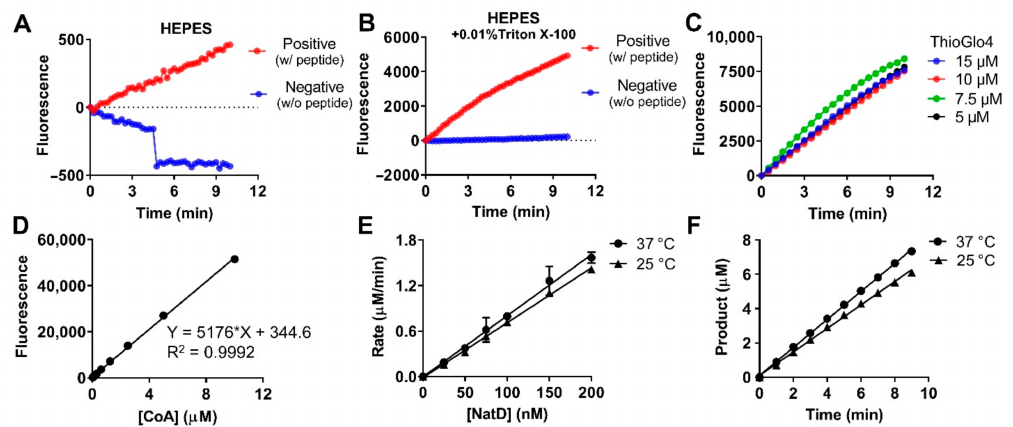
Figure 2. Fluorescence-based NatD activity assay. ( A , B ) The effect of buffer (HEPES with or without 0.01% Triton X-100 in NatD activity. ( C ) The effect of Thioglo4 (5, 7.5, 10, and 15 µ M) on NatD activity. ( D ) Standard curve for the product CoA. ( E ) Linear relationship between NatD concentration and initial velocity at 37 ◦ C (y = 8.05x − 0.003739, R 2 = 0.997) and 25 ◦ C (y = 7.234x − 0.01427, R 2 = 0.9984). ( F ) The linear increase in the concentration of products with time at 37 ◦ C (y = 0.8172x + 0.09484, R 2 = 0.9995) and 25 ◦ C (y = 0.6855x + 0.09642, R 2 =